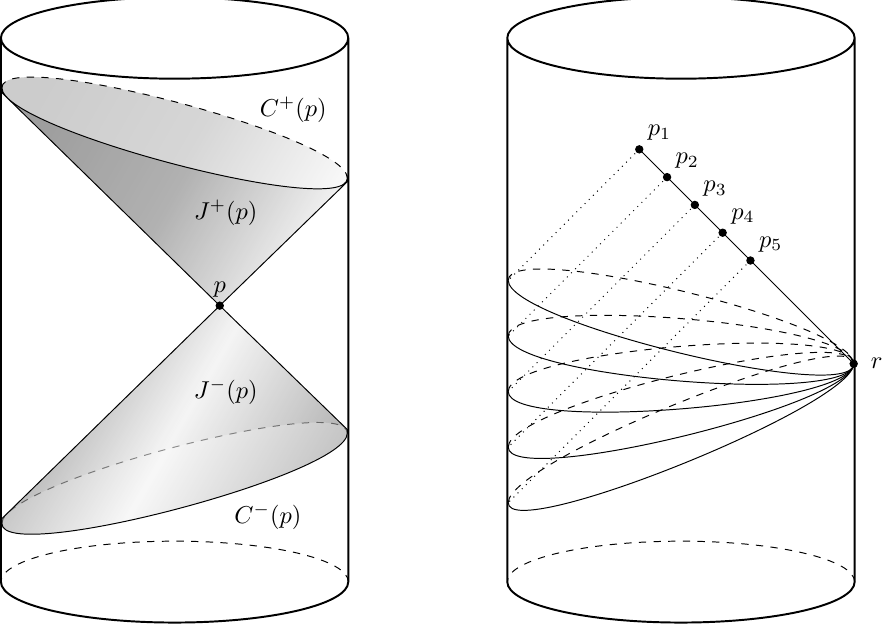
Figure 1 . In the left (cid:12)gure, the shaded region illustrates the future and past light cones @J of a bulk point p M in causal contact with the boundary in an asymptotically AdS spacetime 2 M . Their intersections with the conformal boundary @M de(cid:12)ne the future and past light-cone cuts C (cid:6) ( p ), which are complete spatial slices of @M (cf. properties 1 and 2). The right (cid:12)gure shows how a sequence of null-related bulk points p i M corresponds to a set of light-cone cuts which all f 2 g intersect at a single point r @M (cf. property 2